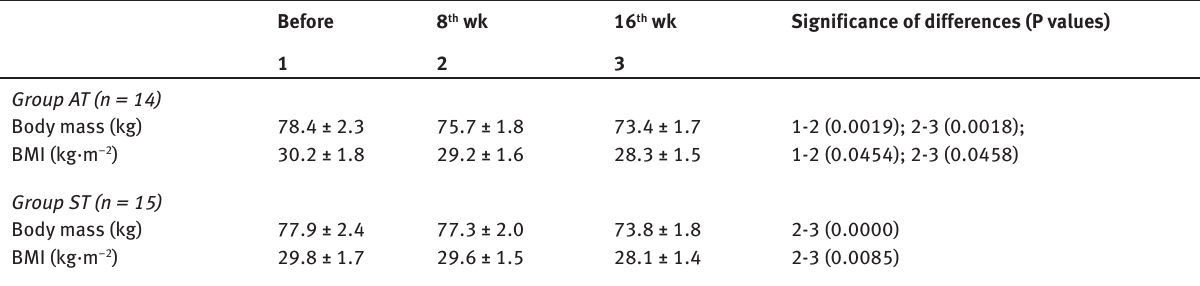
Table 2: Values of body mass and body mass index (BMI) before and after 8 and 16 wks of aerobic (AT) and strength (ST) training of over- weight females (mean ±